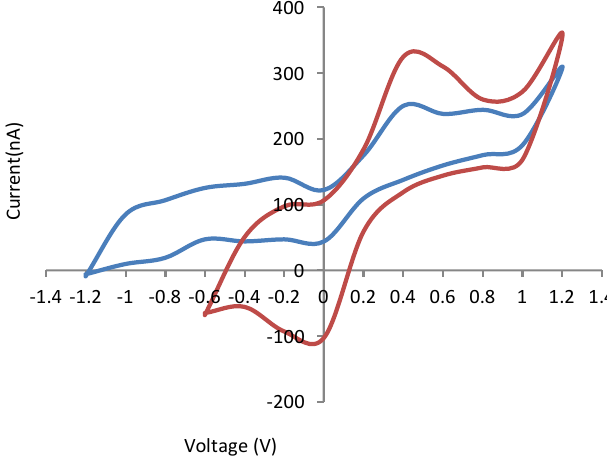
Figure 5. Detection of 7 mM dopamine with non-functionalized (blue) and Figure 13. Detection of 7 mM dopamine with non-functionalized (blue) and functionalized (red) functionalized (red) carbon electrode. carbon